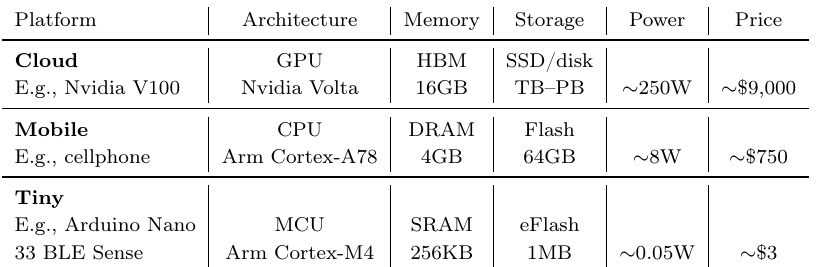
Table 1. Cloud and Mobile ML systems versus TinyML